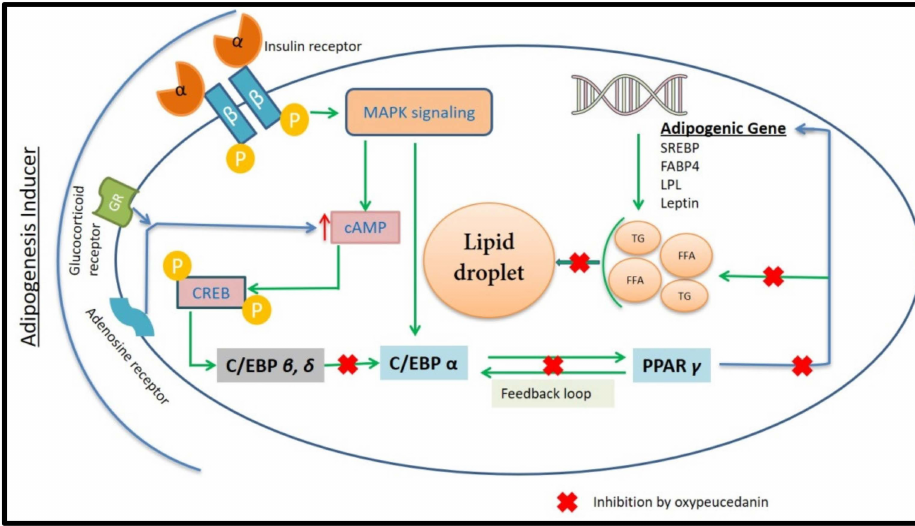
Figure 9. Possible inhibition pathway of oxypeucedanin in